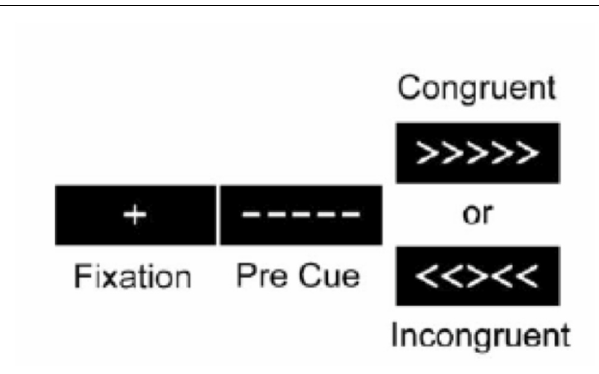
FIGURE 1 |The Eriksen Flanker task that participants completed in during fMRI scanning. Participants were required to indicate the direction of the central arrow (left versus right) while ignoring flanking peripheral arrows as quickly and accurately as possible.